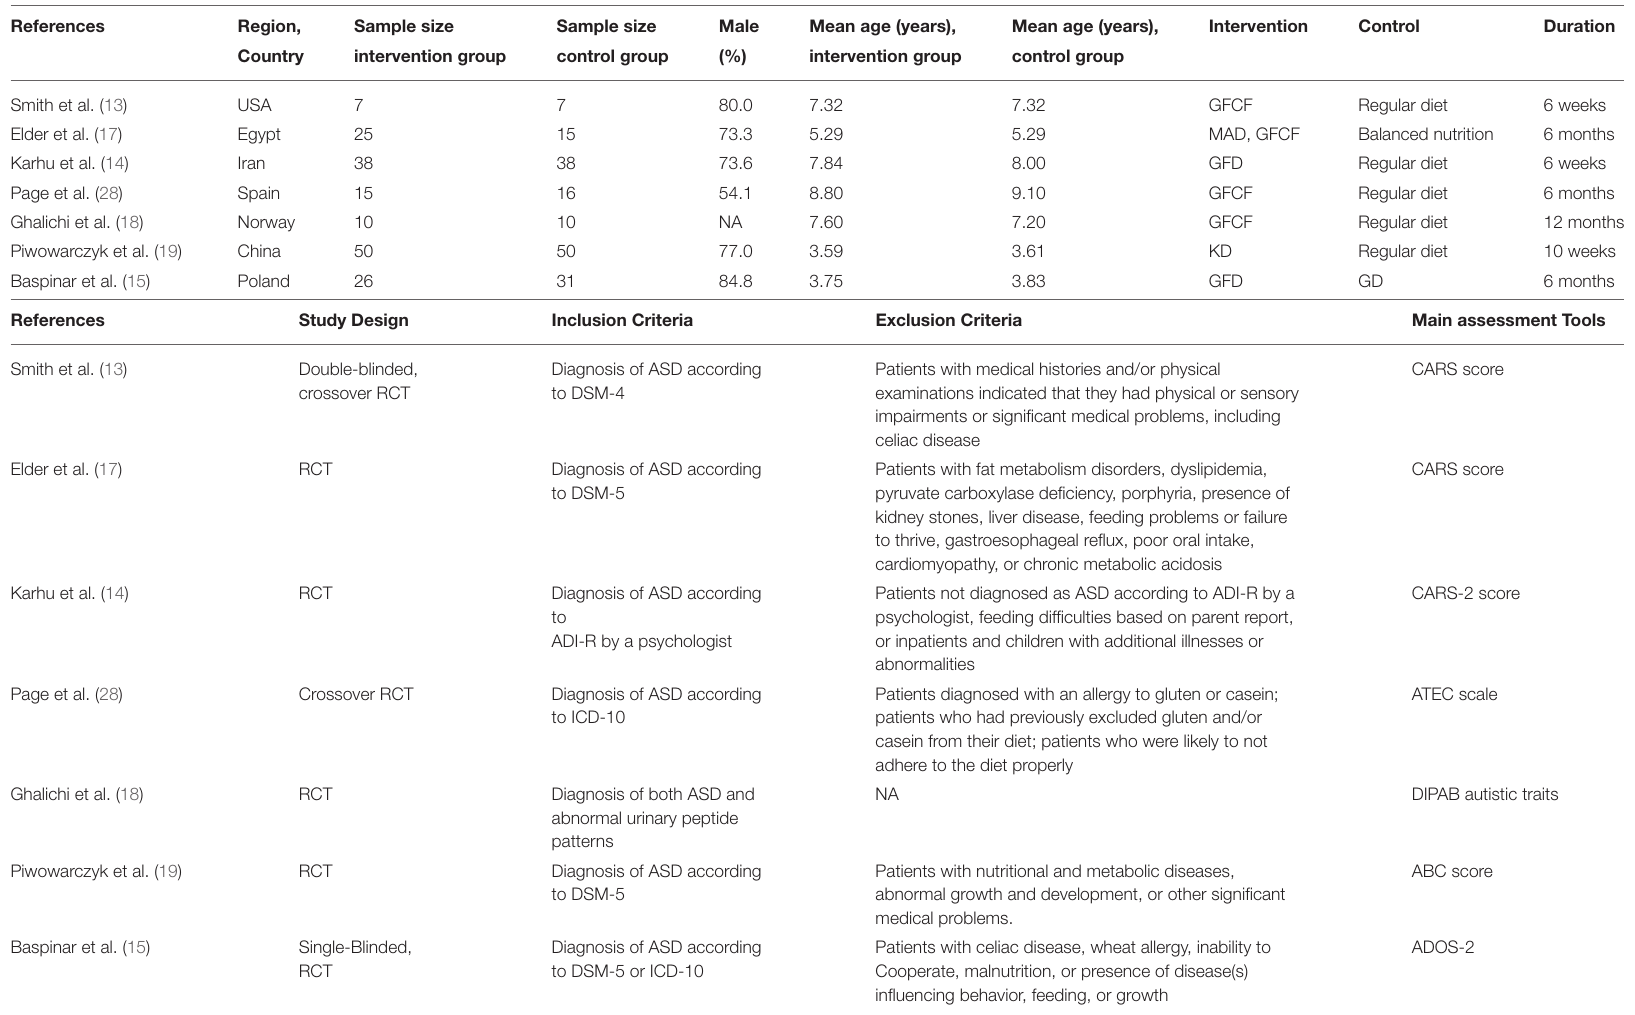
TABLE 1 | The characteristics of the included studies in the